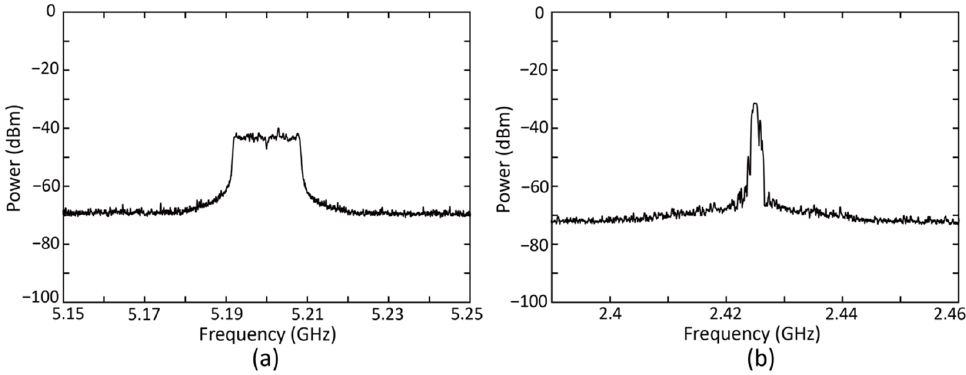
Figure 3. Electrical spectra of ( a ) RF data and ( b ) control signals after 100 m SSMF